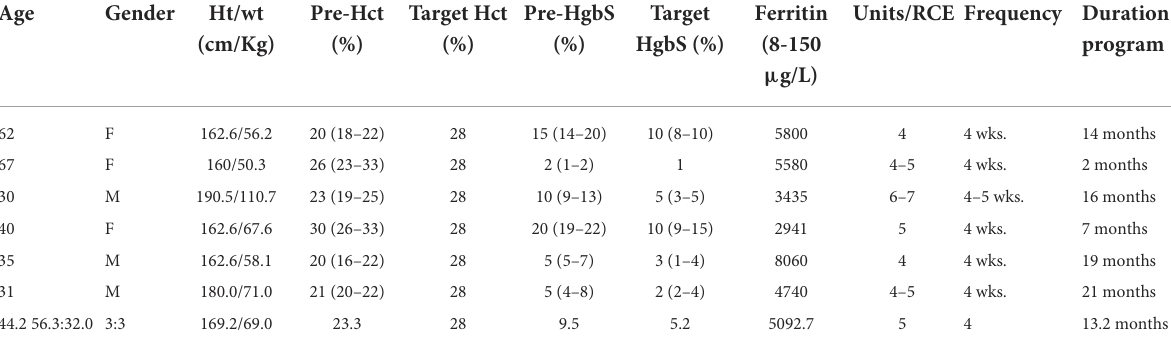
TABLE 1 Demographics and RCE parameters of study